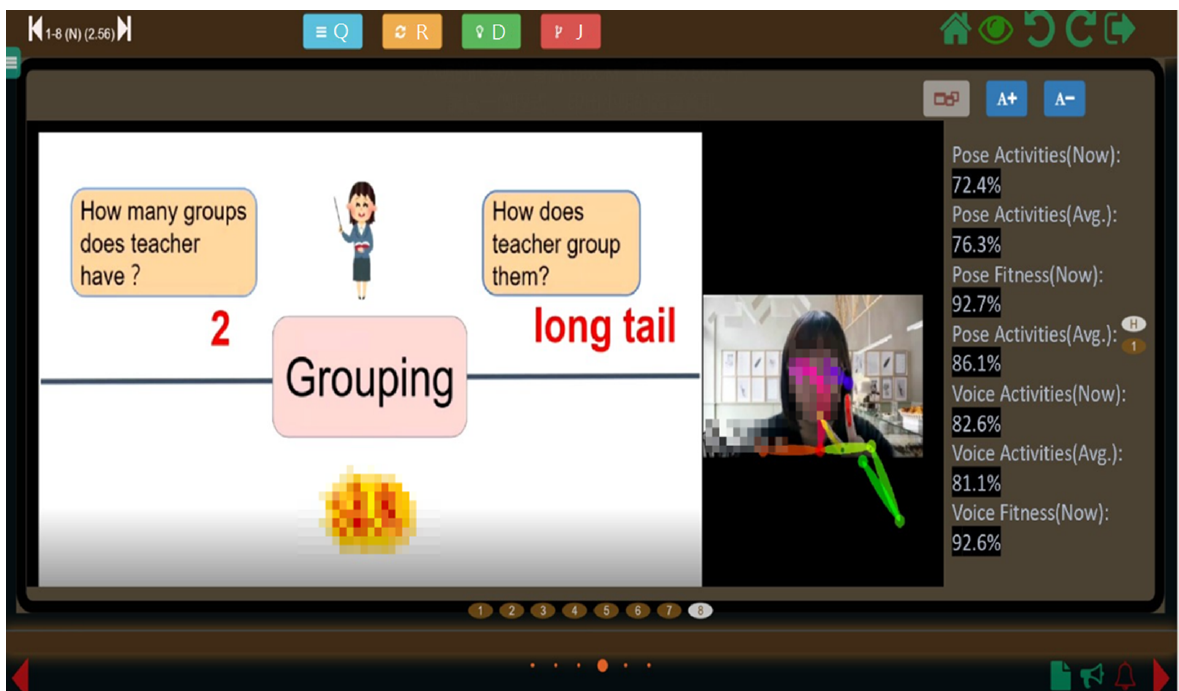
Figure 4. User interface and results for proposed system.